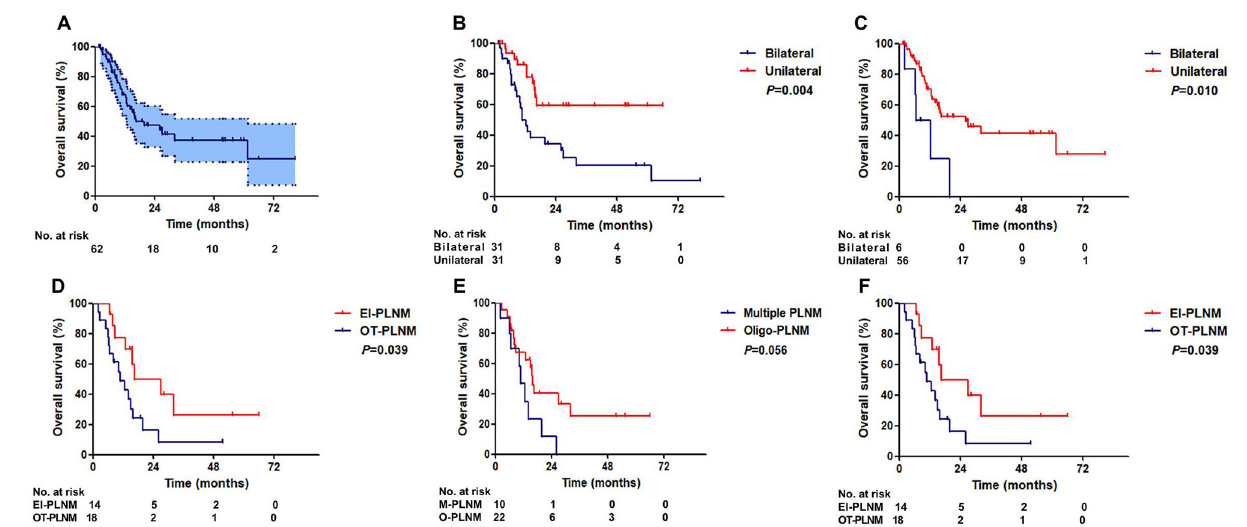
FIGURE 3 | Overall survival of ENE patients. (A) All patients. (B) Patients with unilateral and bilateral inguinal LNM. (C) Patients with unilateral and bilateral ILN-ENE. (D) Patients with and without PLNM. (E) Patients with multiple PLNM and oligo-PLNM. (F) Patients with external iliac region-PLNM and other region-PLNM (EIR-PLNM, external iliac region-PLNM; OR-PLNM, other region PLNM).